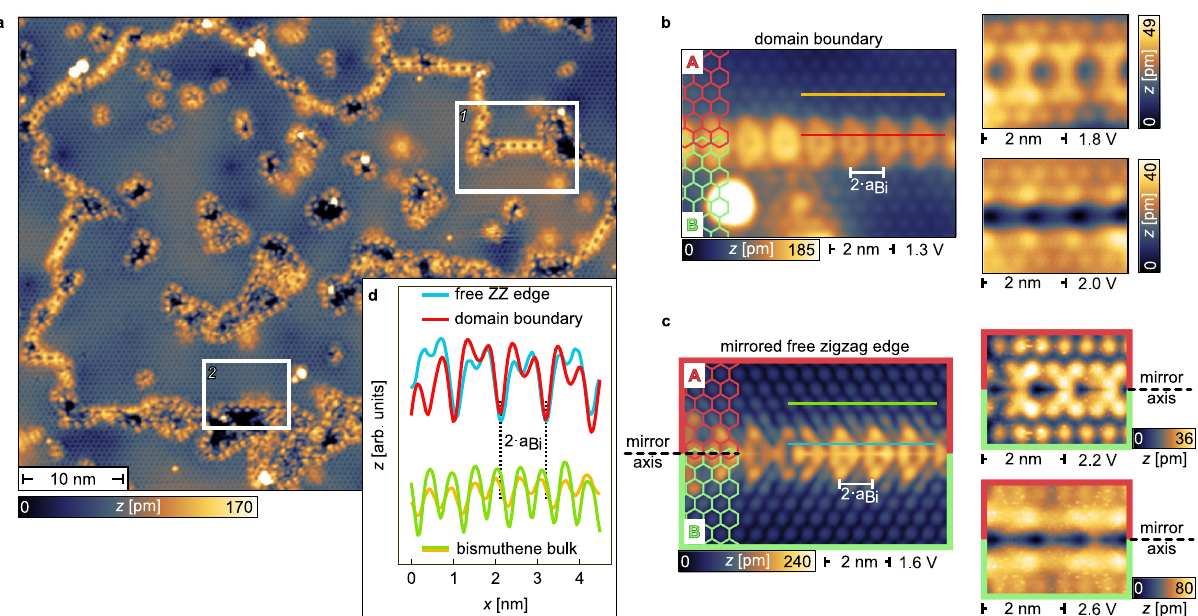
ffiffiffi p ffiffiffi p ´ R 30 (cid:2) 3 3